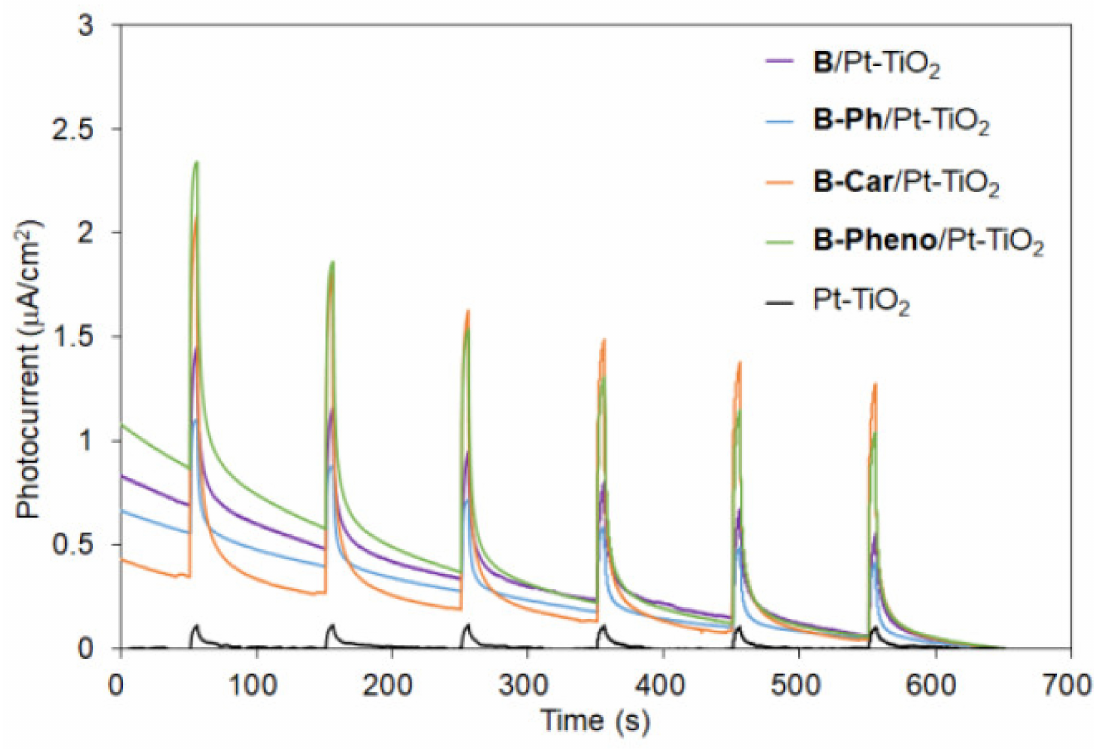
Figure 9. Photocurrent spectra of B, B-Ph , B-Car , and B-Pheno / 0.75wt% Pt-TiO 2 film under visible light (filtered with long path filter of > 420